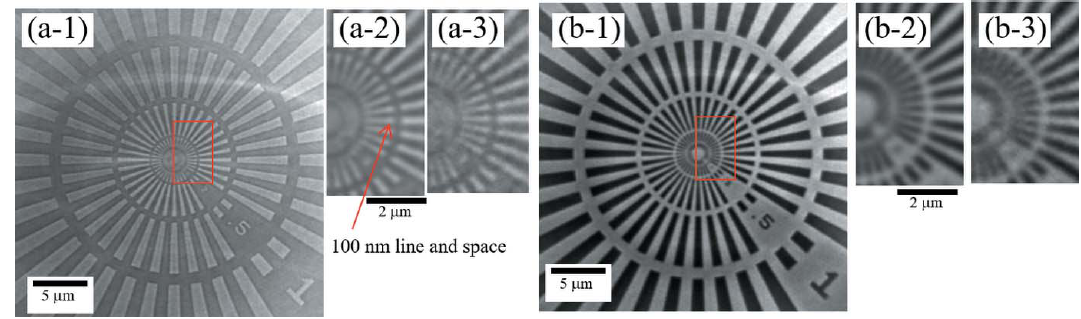
Figure 3 X-ray test chart (NTT-AT XRESO-50HC) images. ( a ) Absorption-contrast image, and ( b ) phase-contrast image with ZPP. Panels ( a -1) and ( b -1) show averaged 50-shot images of each with 100 ms exposure; ( a -2) and ( b -2) show enlarged images of the area indicated by the red squares in ( a -1) and ( b -1), respectively; ( a -3) and ( b -3) show single-shot images of the same positions of ( a -2) and ( b -2) with 100 ms exposure. The area indicated by the arrow corresponds to a 100 nm line and space, which can be clearly identified in both absorption- and phase-contrast images. Comparing the 100 ms single-shot and the 100 ms averaged 50-shot case, similar images were obtained with only a difference in the signal-to-noise ratio, which indicates good temporal stability.